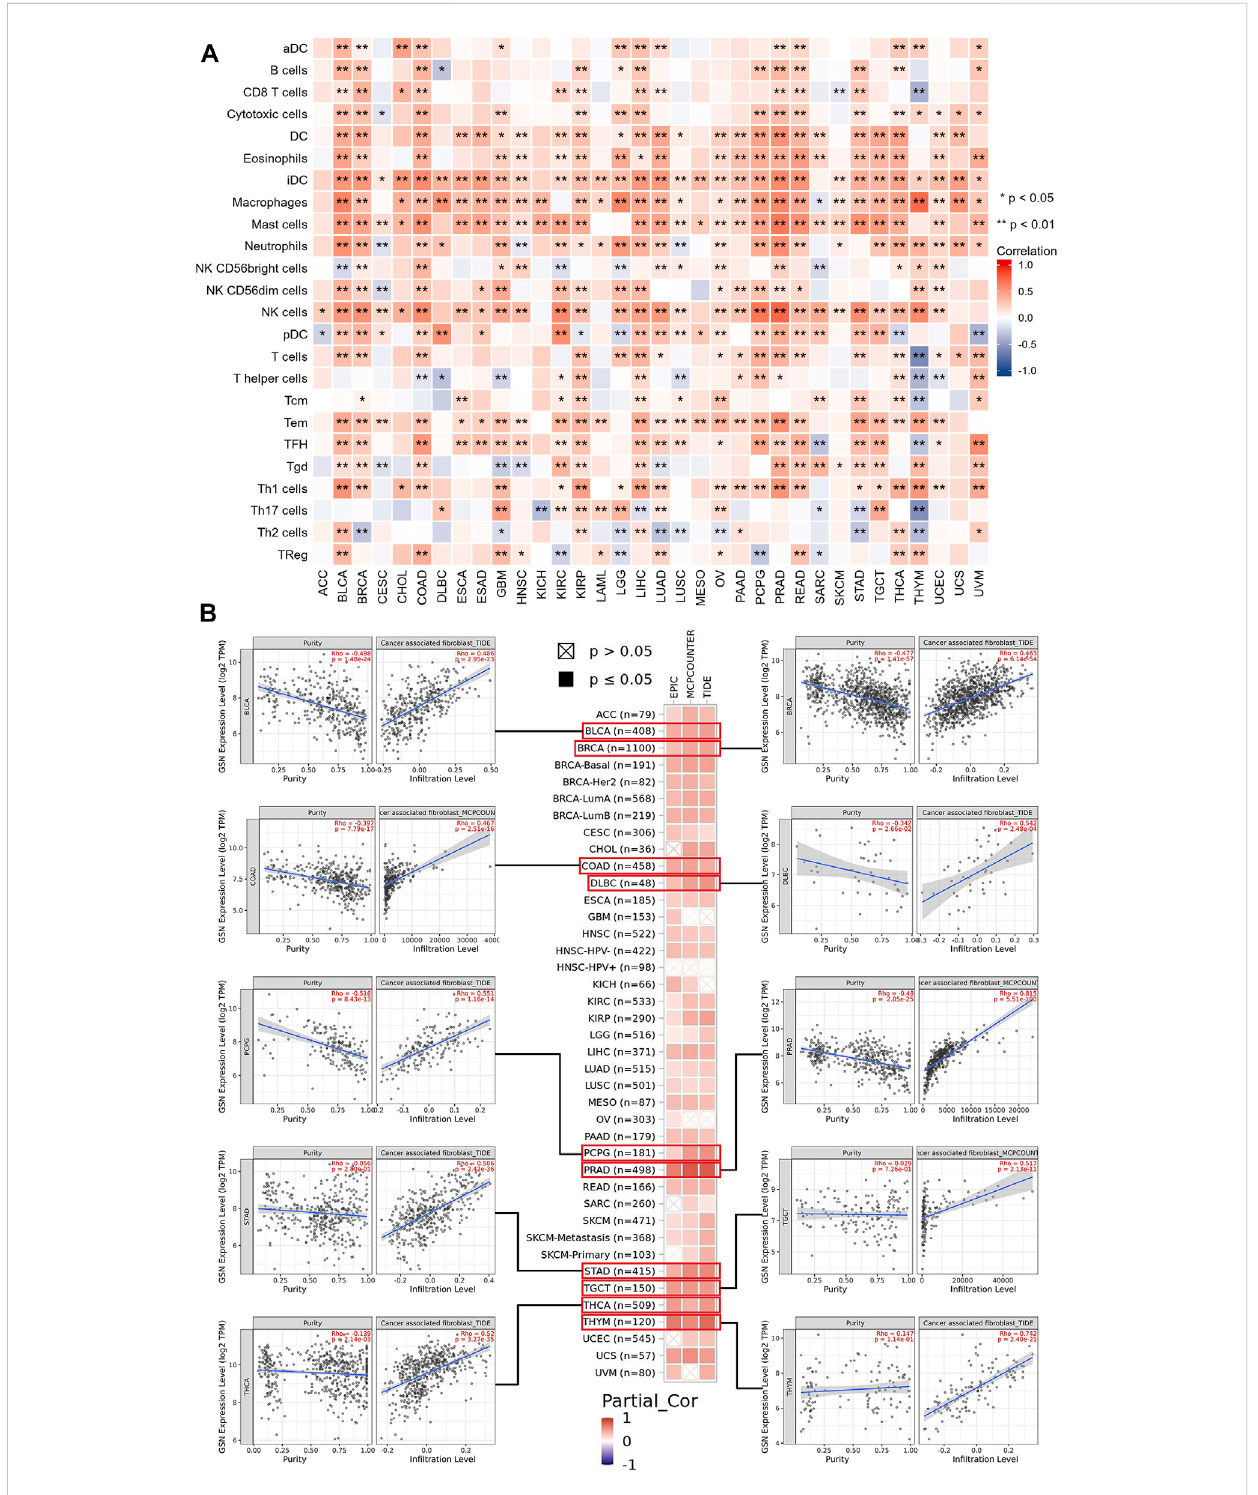
FIGURE 11 Associations between immune cell in fi ltration levels and GSN expression in pan-cancer. (A) The correlation of GSN expression and immune in fi ltration using the ssGSEA algorithm. (B) GSN expression correlation analysis with immune in fi ltration of CAF cells based on Timer2.0 database, scatter plots including BLCA, BRCA, COAD, DLBC, PCPG, PRAD, STAD, TGCT, THCA, and